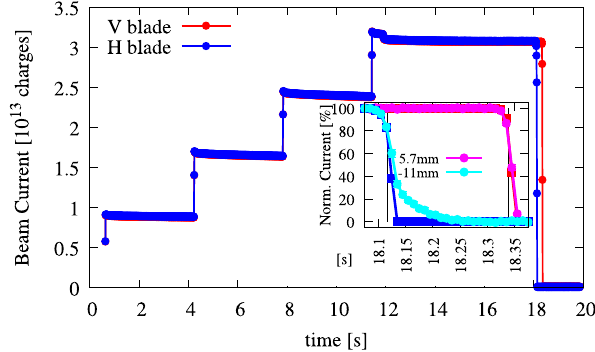
FIG. 6. BCT signals during the endurance test of the horizontal (blue curve) and the vertical (red curve) blades. The inset, focused on the moment of scraping, compares the normalized signals at scraping from the test (dark colors) to those obtained with low- intensity beams (light colors) for the same scraper settings (see Sec. III A and Fig. 4). When visible, error bars on the signal from the test refer to the LSB. The black vertical bars in the inset mark the time of the dump.